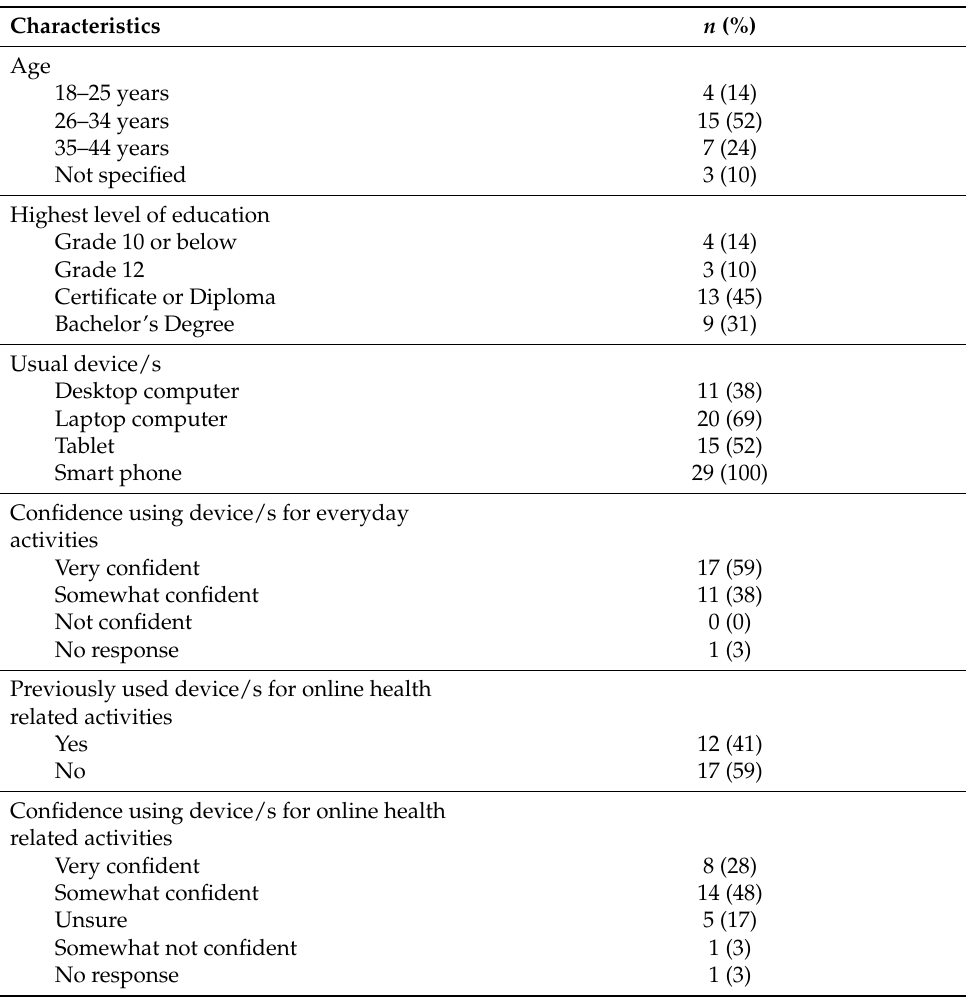
Table 2. Parent demographics and technology experience/confidence ( n = 29)